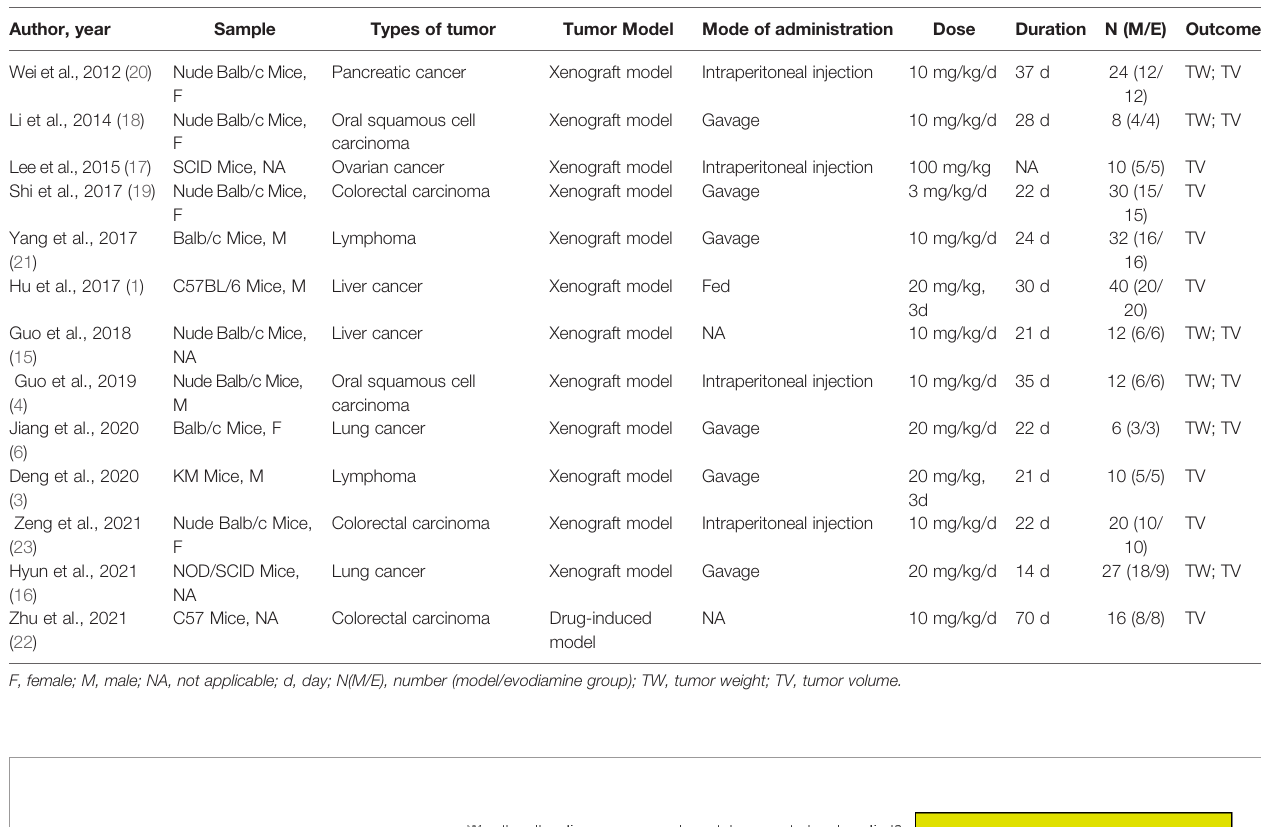
TABLE 1 | Characteristics of included studies.